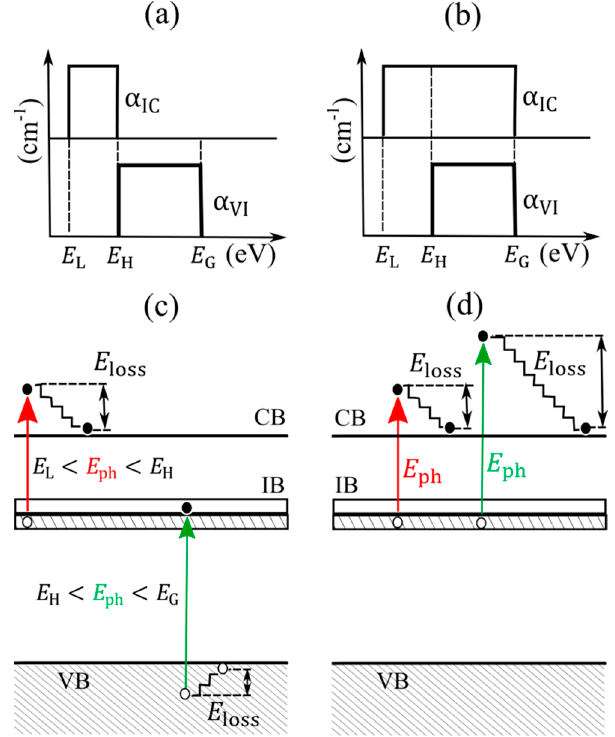
Figure 2. Illustration of non-overlapped ( a ) and overlapped ( b ) absorption coefficients corresponding to inter-band transitions from the IB to the CB ( α IC ) and from the VB to the IB ( α VI ). The resulting photon absorption processes are illustrated ( c , d ), separately, together with the corresponding thermalization losses ( E loss ).